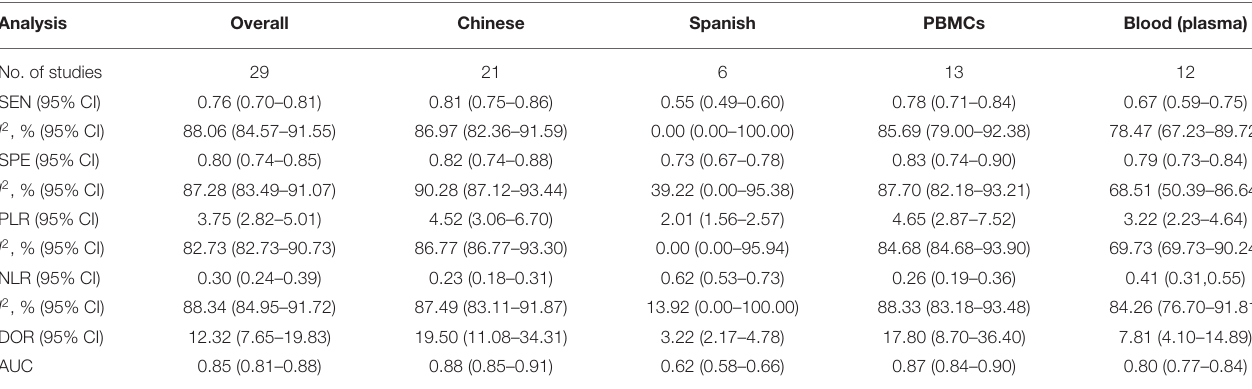
TABLE 3 | Diagnostic performance of miRNAs in AS